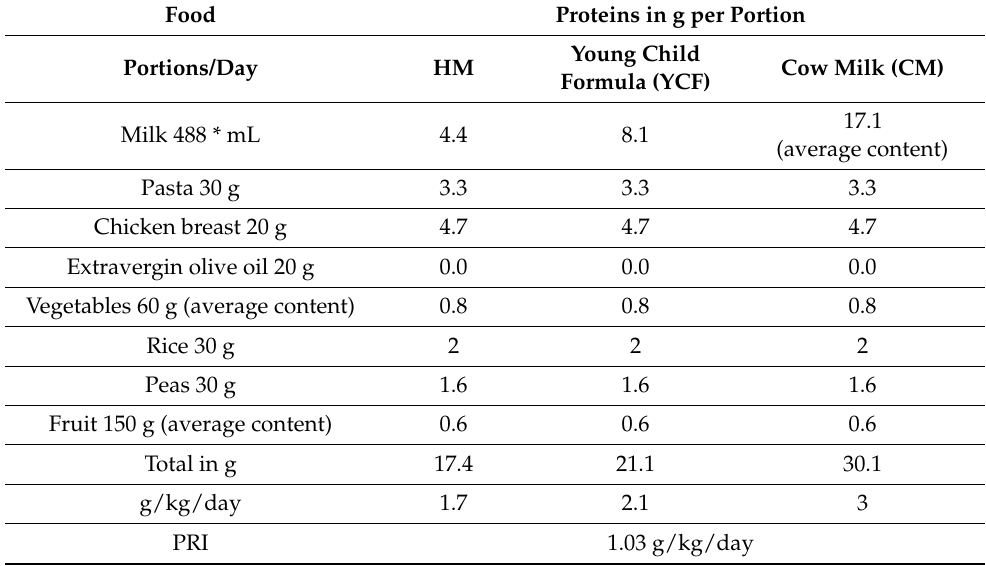
Table 5. Different protein intakes for an infant of around 18 months of age weighing approximately 10.2–10.9 kg [32] when breastfed, fed with YCF or CM, using a single scheme of intake of solid foods commonly used by the family, and the same portion of milk, and considering a PRI for protein of 10.1–13.7 g/day (1.0–1.3 g/kg) [34]. The amount of milk * is defined according to Dewey’s observational data